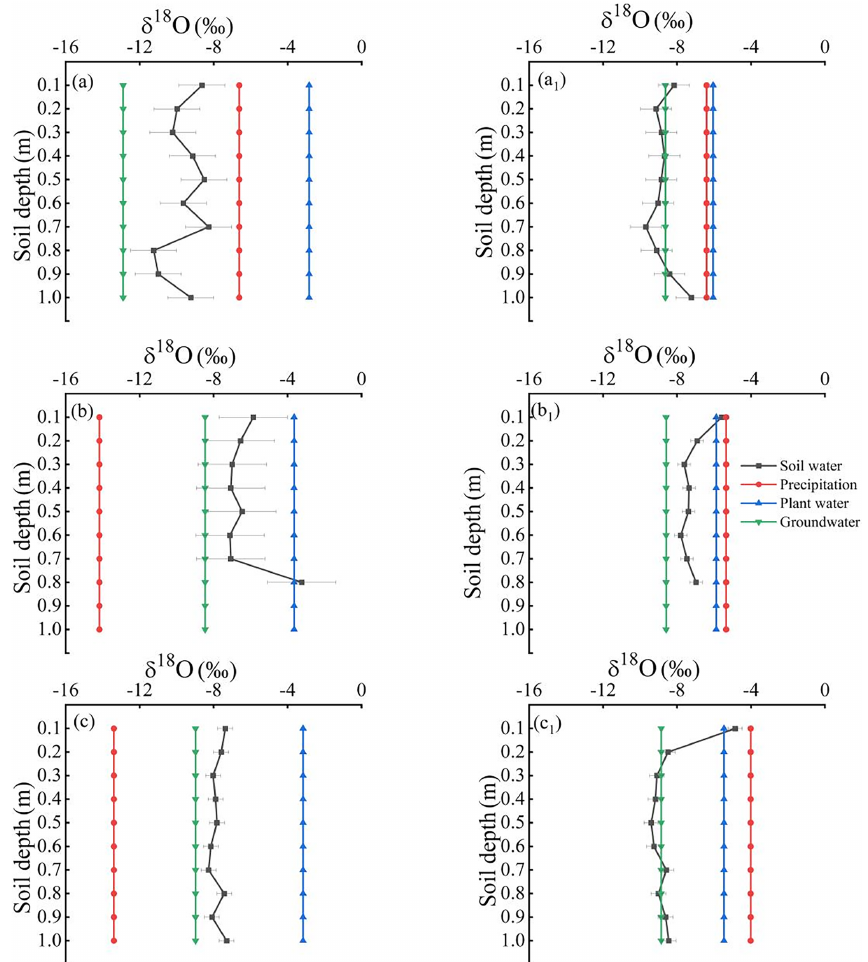
Figure 4. Panels (a–c) represent the variation in δ 18 O of soil, plant, precipitation, and groundwater with soil depth in the alpine meadow, forests, and arid foothills in the dry season, and panels (a1–c1) represent the variation in δ 18 O of soil, plant, precipitation, and groundwater in the alpine meadow, forests, and arid foothills in the rainy